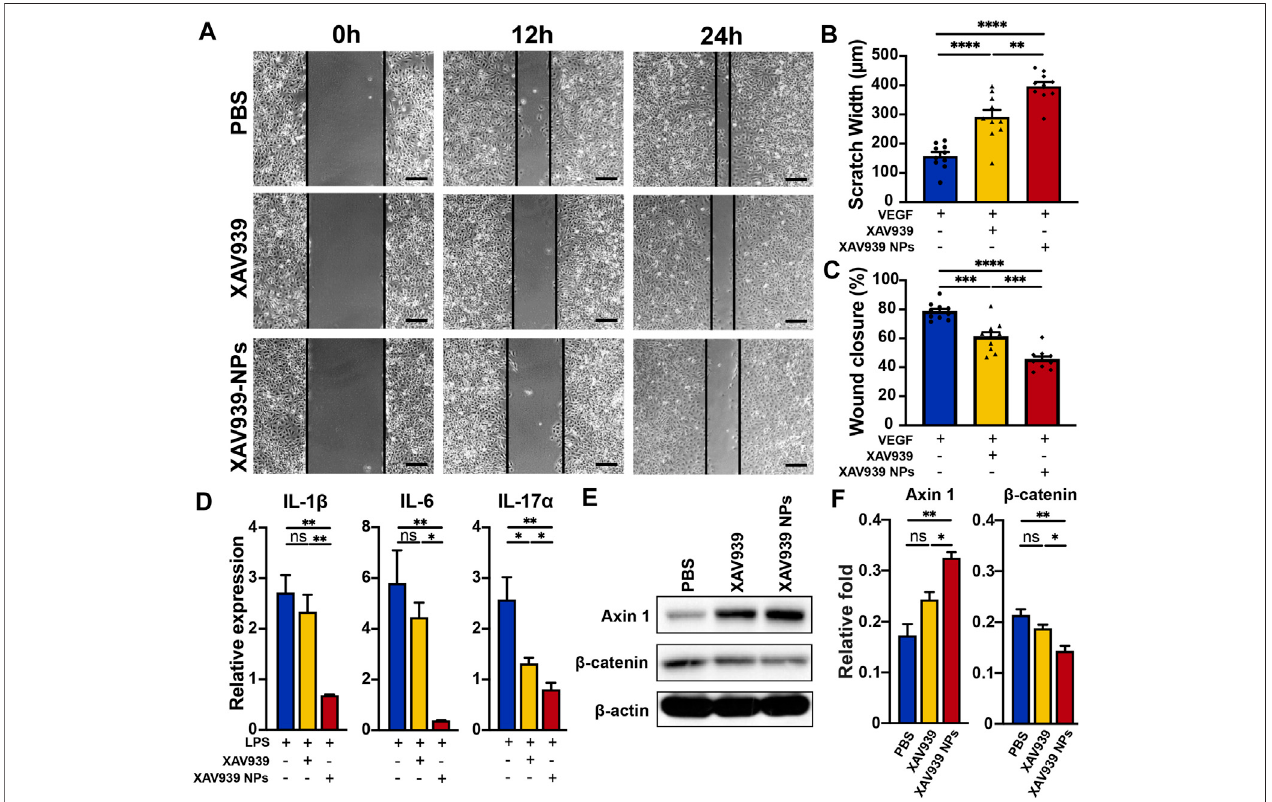
FIGURE 3 | In vitro antiangiogenesis and anti-in fl ammatory effects through Wnt/ β -catenin signaling pathway regulation. (A) Scratch wound migration assay of HUVECs stimulated with rhVEGF 165 (1 μ g/ml) following exposure of PBS, XAV939 (10 μ M), and XAV939 NPs (10 μ M XAV939 equivalent). Scale bar: 200 μ m. Quanti fi cation of the scratch widths (B) and the percentage of wound closure (C) . Results are presented as the mean ± SEM. n (cid:2) 10. (D) Relative expression of mRNA levels of IL-1 β , IL-6, and IL-17 α of HCEs stimulated with LPS (1 μ g/ml) following exposure of PBS, XAV939 (10 μ M), and XAV939 NPs (10 μ M XAV939 equivalent). Results are presented as the mean ± SEM. n (cid:2) 3. Western blot analysis (E) and quanti fi cation of the relative protein levels (F) of Wnt pathway components Axin 1